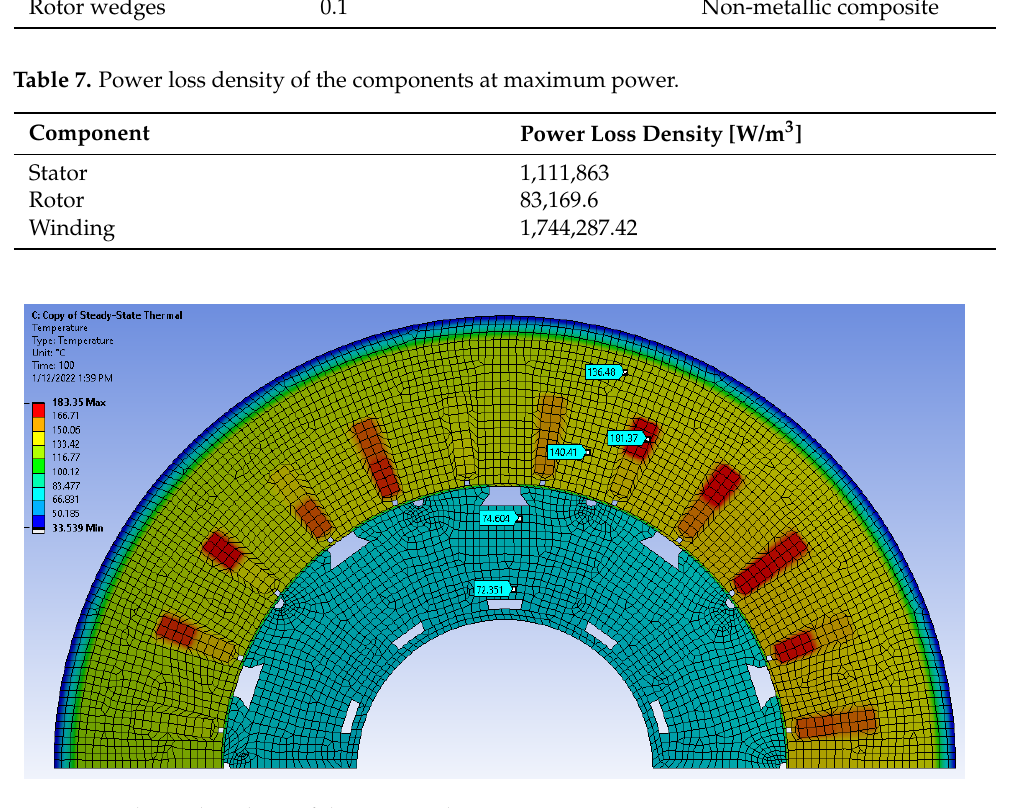
Figure 16. Thermal analysis of the proposed 6Φ -S-FSCW-Fer-SPMSM at maximum